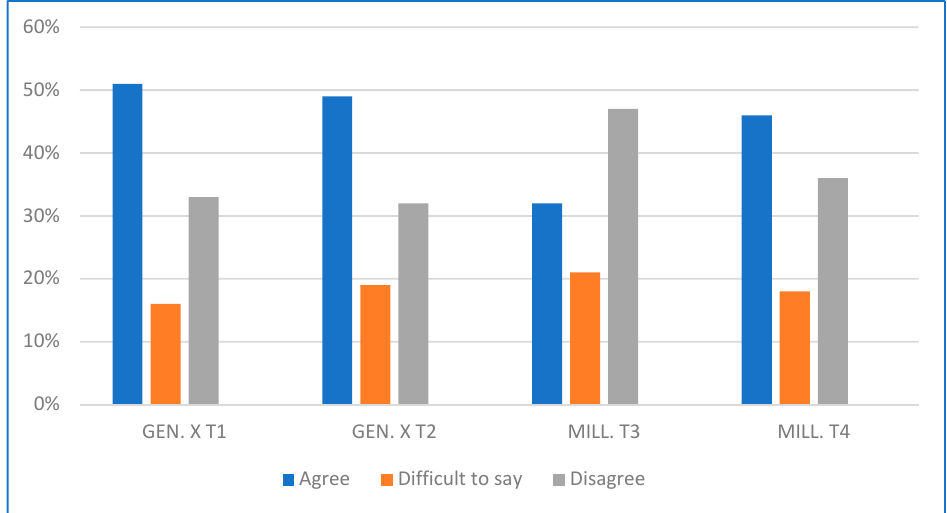
Figure 1. Development aid to foreign countries should not be increased so long as there are people in need in Finland .